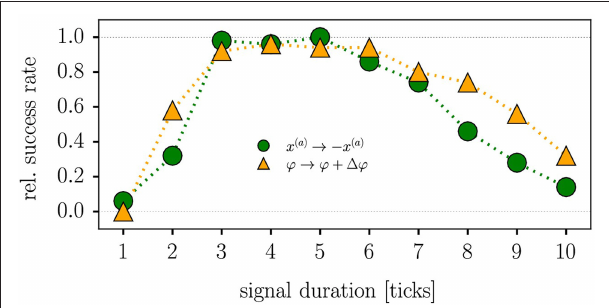
FIGURE 6 | Reliability of quenched kick control procedures for the LEGO Mindstorms robot in terms of the relative success rate when testing direction reversal. The parameters are τ = 250ms, k = 8 and a = 4, with each data point corresponding to the average of 50 trials. The duration 1 t of the control signal is given in terms of ticks, with a tick corresponding to the period of the control cycle of the Lego robot (about 30ms). Maximal reliability is achieved for 3–5 ticks (90–120ms), both for reversing the actual position x ( a ) [compare (11), green circles] and when adding a phase-shift of 1ϕ = ± 3 π/ 4 to the angle of the wheel [as defined by (12), orange triangles]. A positive 1ϕ induces here a transition from forward to backward locomotion (reversely for negative 1ϕ